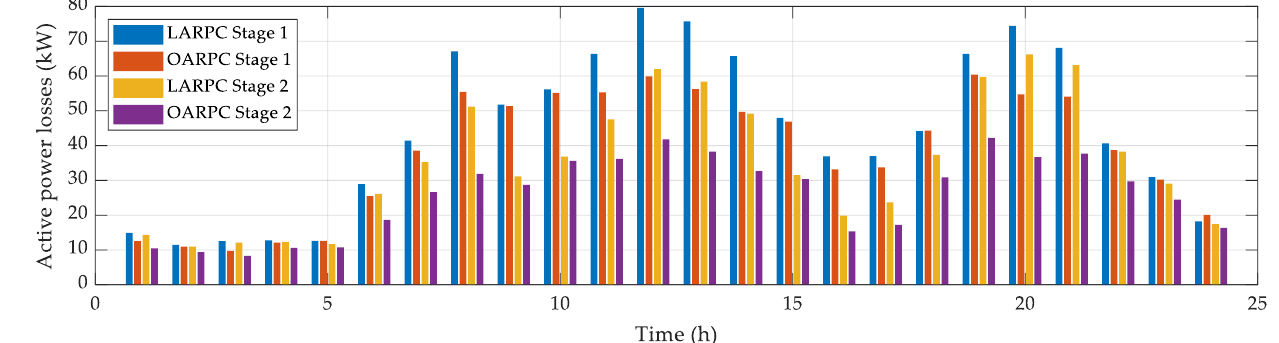
Figure 14. Hourly active power losses profile comparison for both stages of OARPC and LARPC.